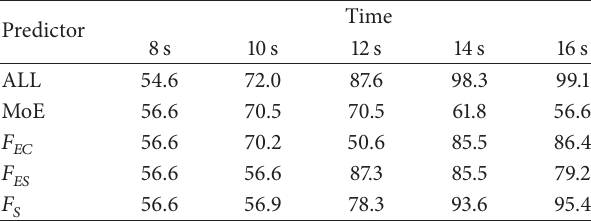
Table 4: Time-evolution of the accuracy of selected predictors